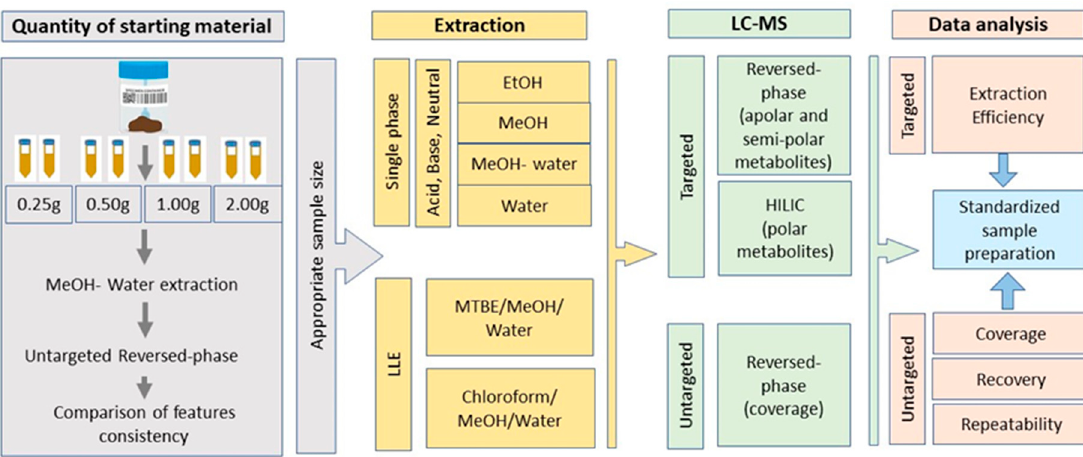
Figure 1. Experimental workflow and sample treatment